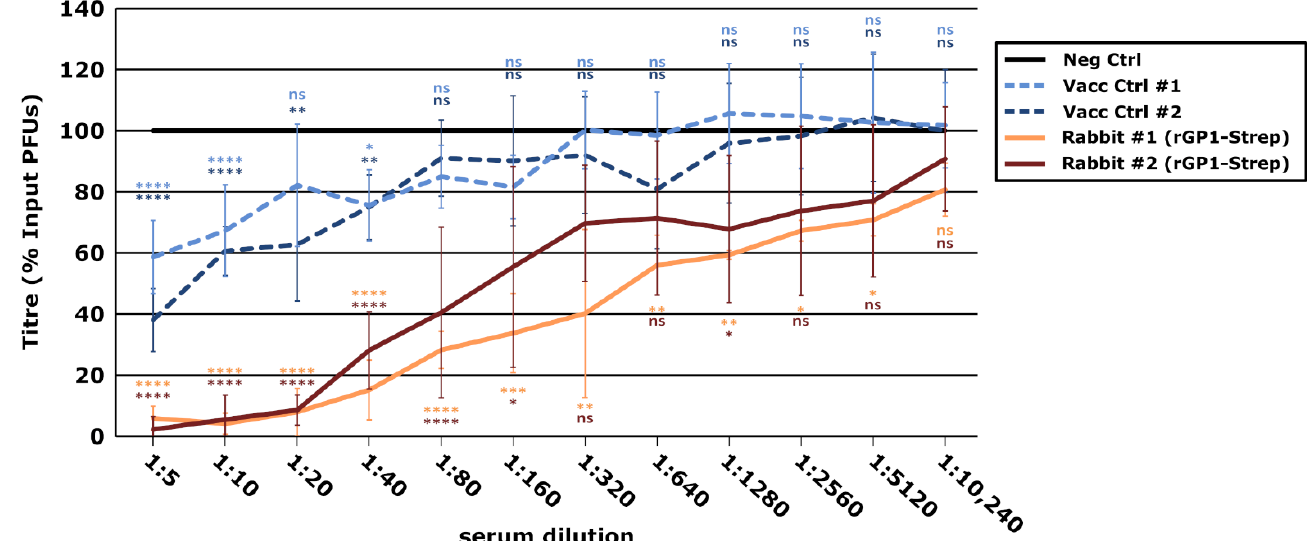
Figure 5. Assessment of neutralizing antibody development following vaccination with recombinant Junín virus (JUNV) GP1 based on the plaque reduction neutralization test. JUNV (strain Cba IV4454) diluted to 10 3 pfu/mL was mixed 1:1 with serum from rabbits vaccinated with recombinant JUNV GP1-Strep or from a naïve rabbit. Serum from human Candid#1 vaccinees (Vacc Ctrl) or a